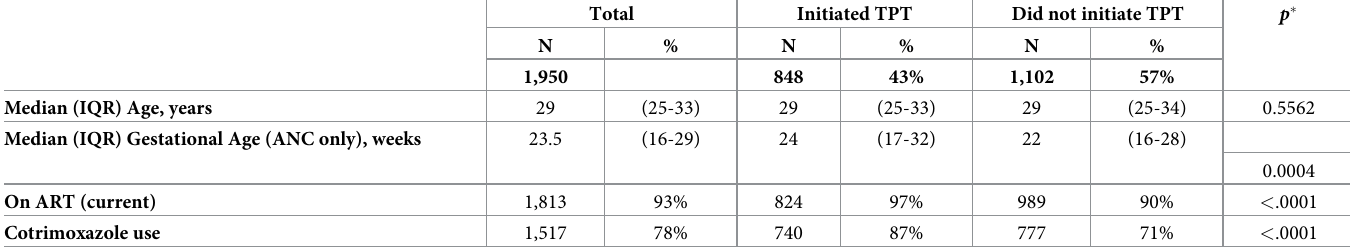
Table 2. Characteristics of HIV-positive women with a negative TB screen by TB Preventive Treatment (TPT) initiation status at four health facilities in Eswatini, 2017 (N = 1,950).